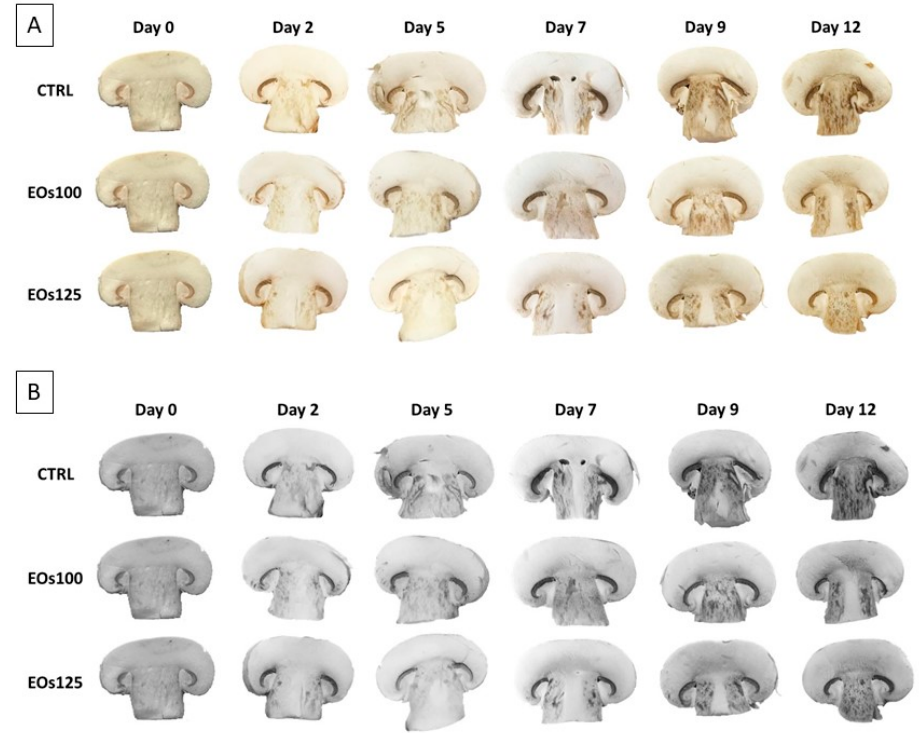
Figure 2. Sliced mushroom during cold storage (4 ◦ C) under modified atmosphere packaging supplemented with vapour essential oils (100 and 125 µ L L − 1 EOs). ( A ) Original RGB image; ( B ) BW image.